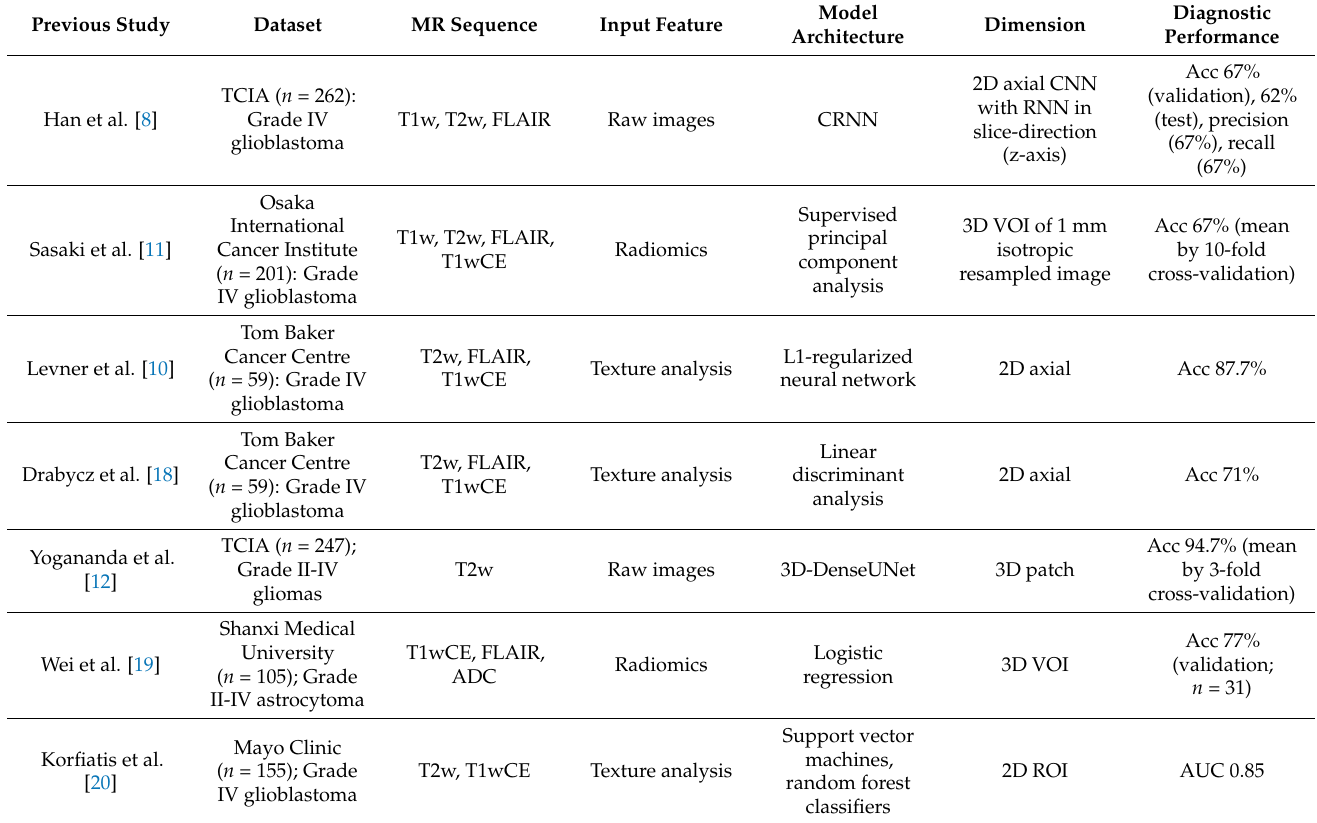
Table 2. Comparison of previous prediction models of MGMT